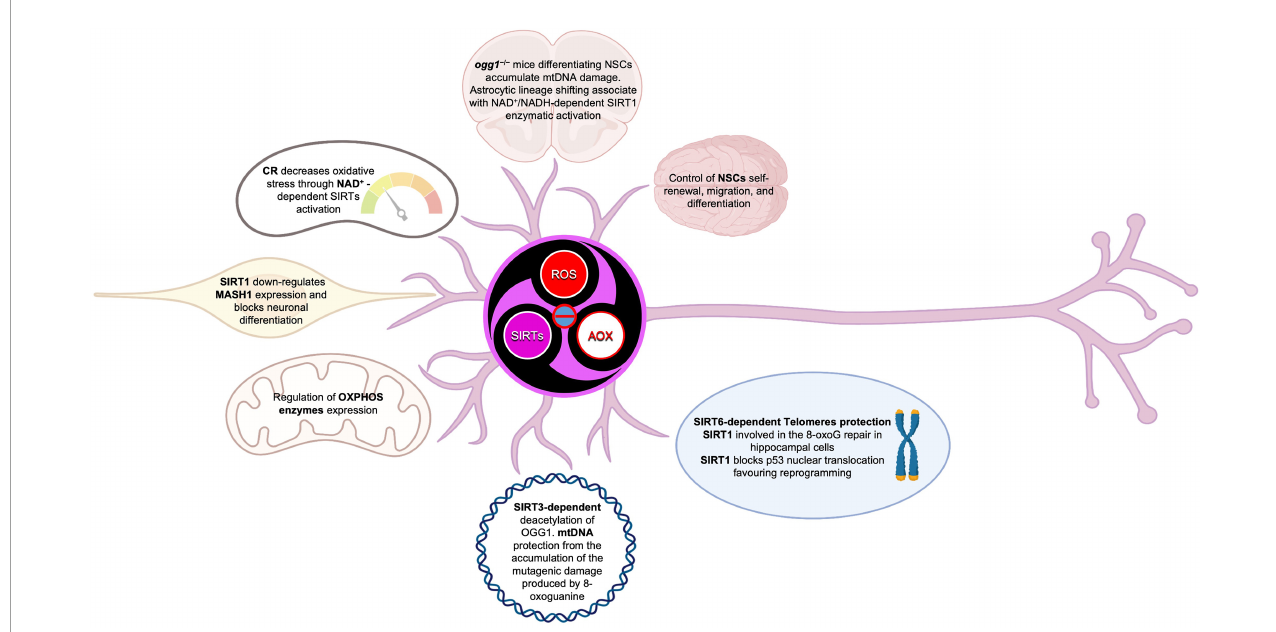
FIGURE10 Sirtuins in the brain build up a connection between epigenetic and metabolism. SIRTs act as modulators in a complex molecular network, under direct and indirect ROS control. SIRTs-ROS/AOX balance affects NSCs fate, reprogramming, and aging, mainly through mitochondria physiology regulation and telomere